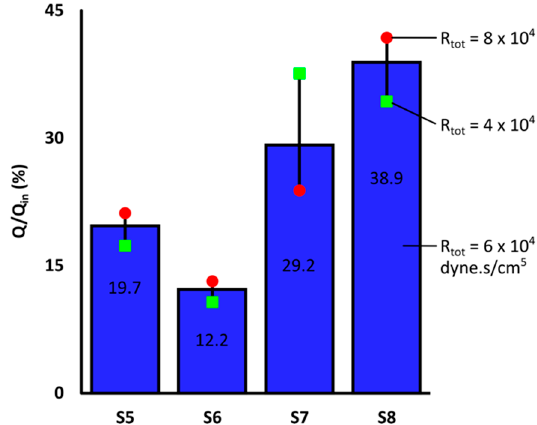
Figure 6. Blood flow distribution between right liver segments for R d / R p = 1 with S7 R tot = 6 × 10 4 dyne·s/cm 5 . S7 included blood flow to the tumor. Black lines show the blood flow fluctuations due to S7 R tot variations in the range of [4,8] × 10 4 dyne·s/cm 5 .